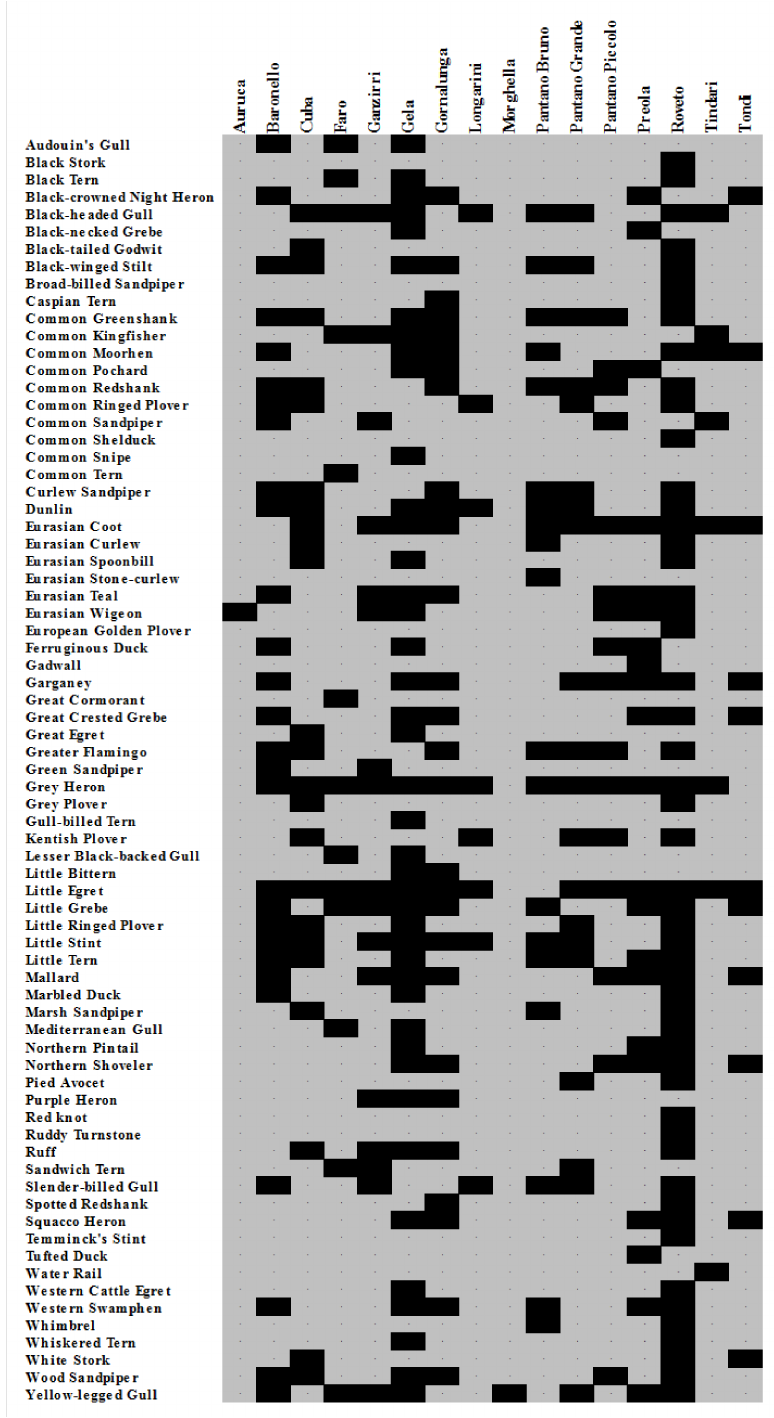
Figure 2. Species-by-site incidence matrix. Darker cells indicate presences and lighter ones stand for